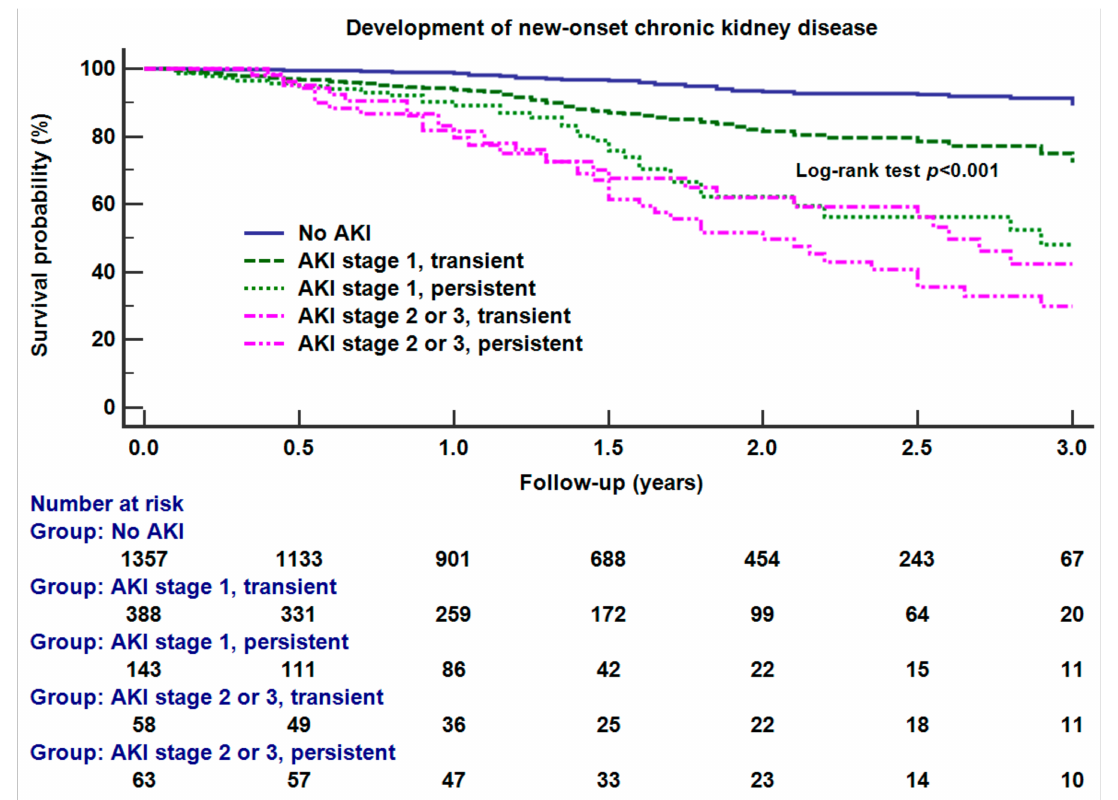
Figure 1. Kaplan–Meier survival curve analysis between different groups of acute kidney injury (AKI), i.e., no AKI, transient stage 1, persistent stage 1, transient stage 2 or 3, persistent stage 2 or 3. The results of the overall log-rank test were shown in the figure. There were significant differences in survival between transient and persistent stage 1 AKI (log-rank test p = 0.002) and between transient and persistent stage 2 or 3 AKI (log-rank test p = 0.010). The transient stage means that the